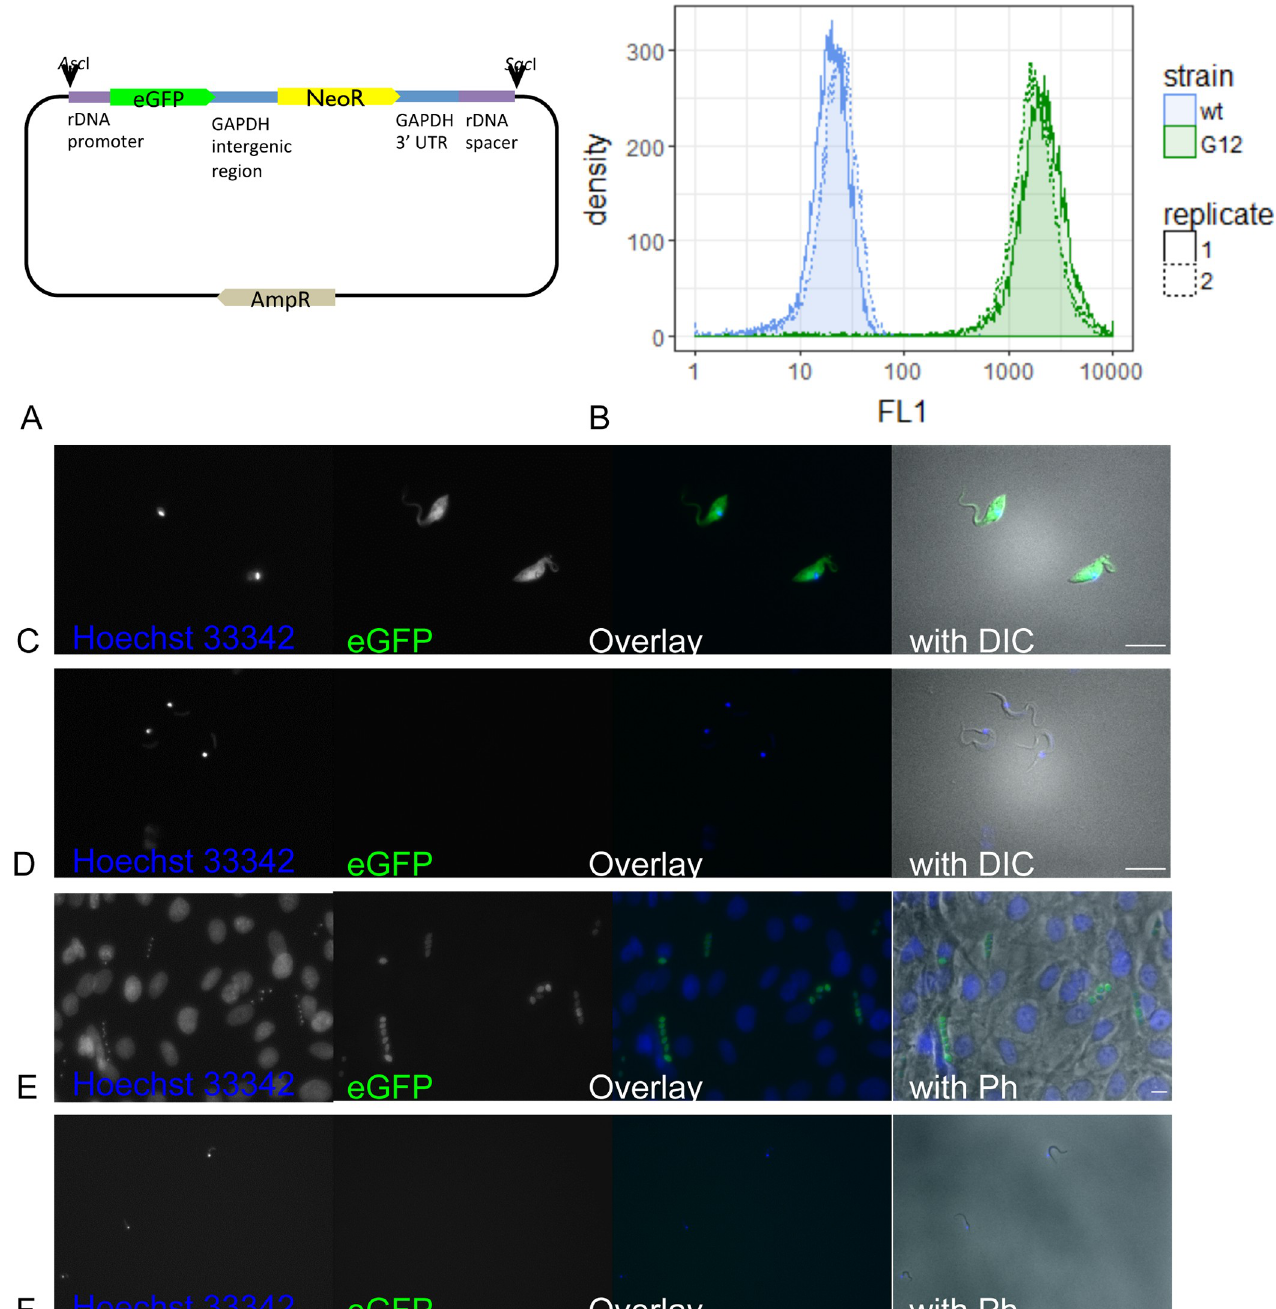
Fig 1. Transgenic parasites transfected with pTRIX2-eGFP. (A) The plasmid pTRIX2-eGFP was constructed by inserting the enhanced green fluorescent protein gene into the T . cruzi rDNA targeting plasmid pTRIX2-RE9h [28]. (B) Fluorescence levels of transfectant (G12) and wildtype (wt) epimastigotes were measured with flow cytometry. Epifluorescent images of transfectants in epimastigotes (C), metacyclic trypomastigotes (D), amastigotes in MEF (E), and trypomastigotes (F). Epimastigotes and metacyclic trypomastigotes were imaged with 630x magnification for 200 ms on DIC, 100 ms with the A4 filter cube (Hoechst 33342), and 300 ms with the L5 filter cube (GFP). Amastigote-infected MEF and trypomastigotes were imaged with 400x magnification for 50 ms with phase-contrast, 50 ms with the A4 filter cube (Hoechst 33342), and 815 ms with the L5 filter cube (GFP). Scale bars represent 10 μ m.